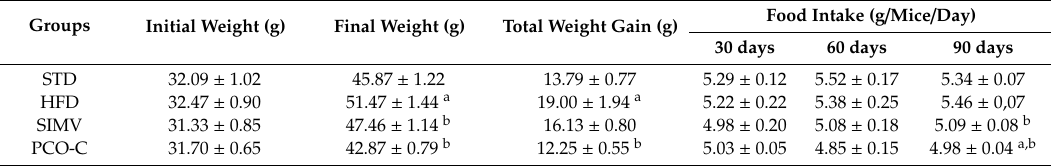
Table 6. E ff ects of PCO-C on weight gain and food intake of mice that were subjected to the hypercholesterolemic diet and controls.